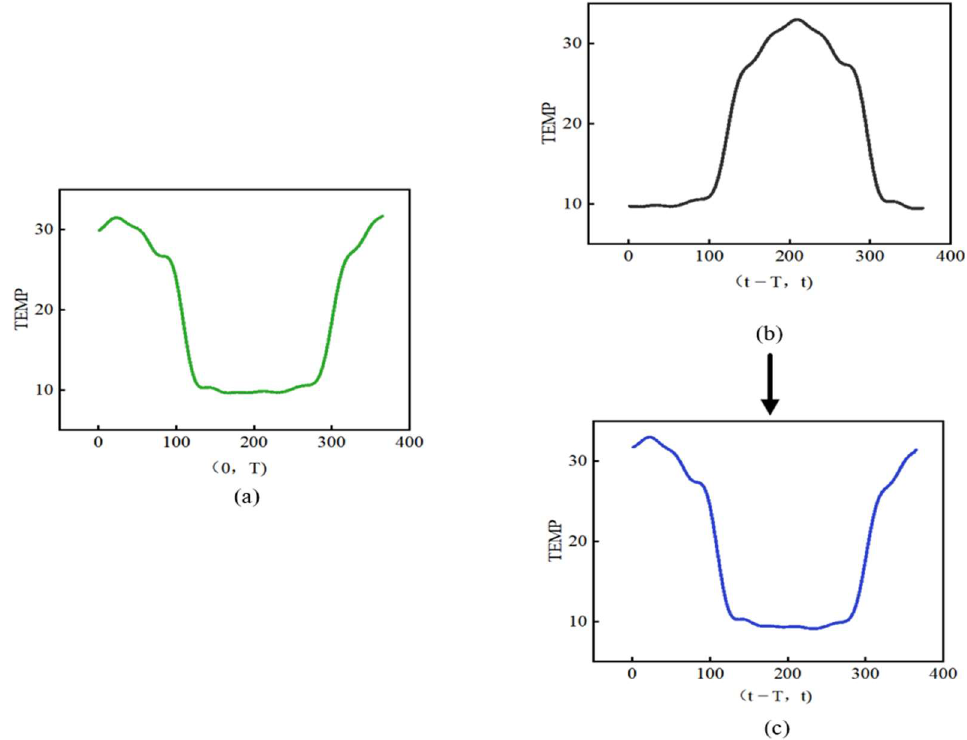
Figure 3. Diagram of the effect of real-time operational data rearrangement. ( a ) is the data change curve for the benchmark (0, T] interval of the parametric health state. ( b ) is the data change curve for the (t − T, t] interval of the complete operating cycle at time t. ( c ) is the change curve after rearranging the data for the (t − T, t] interval of the complete operating cycle at time t.